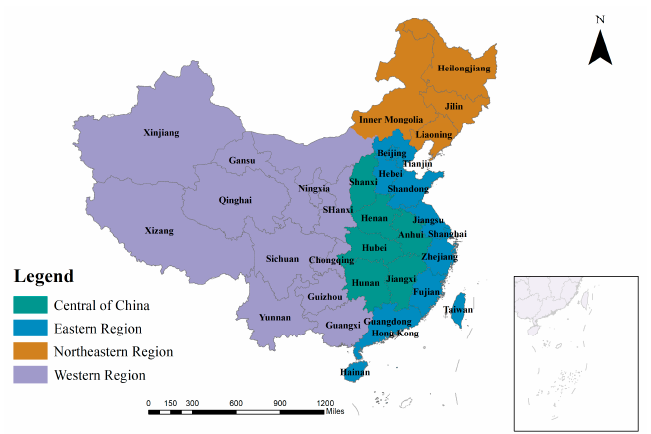
Figure 1. The study area: China’s 34 provincial administrative units and four economic regions.